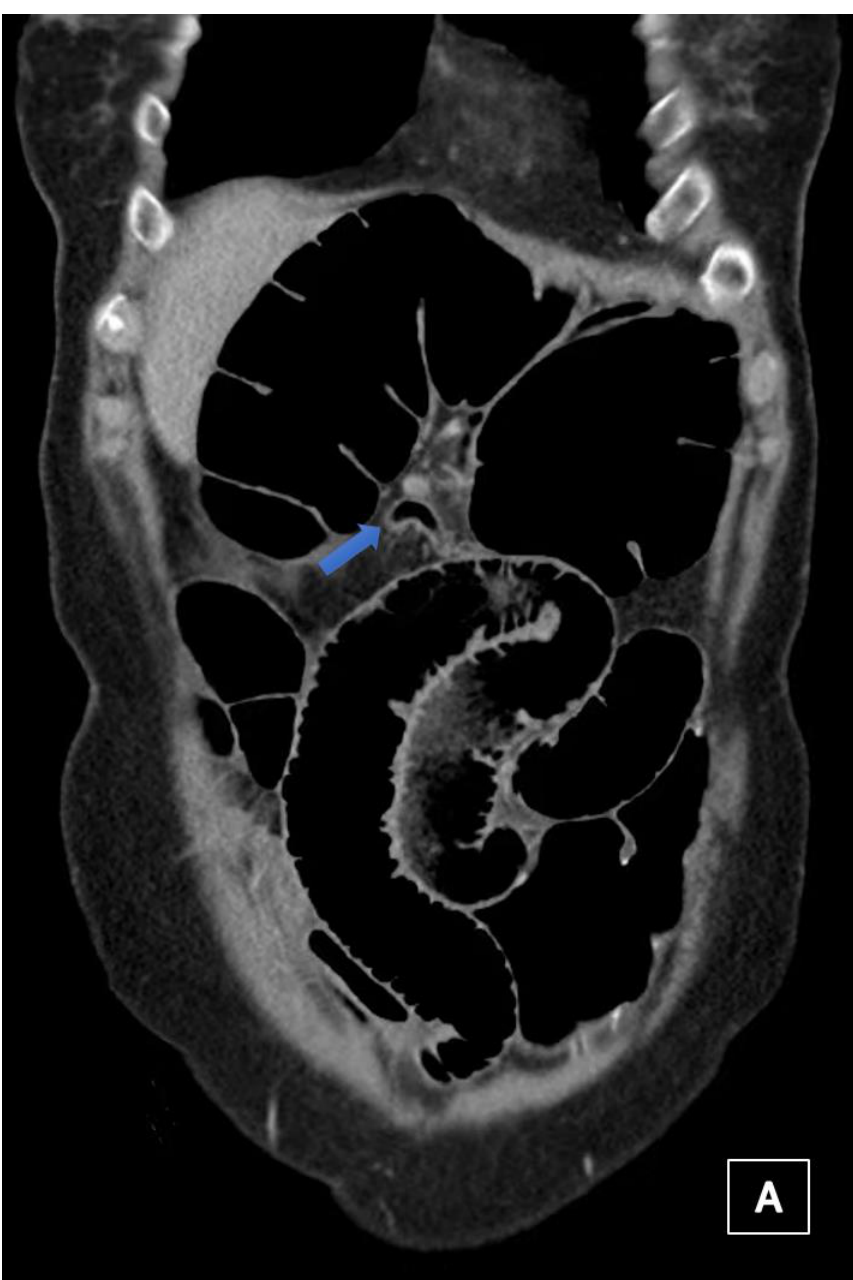
Figure 7. CT coronal image demonstrating a central appendix sign where there is a dilated gas-filled appendix (blue arrow). The caecum and proximal small bowel loops are also